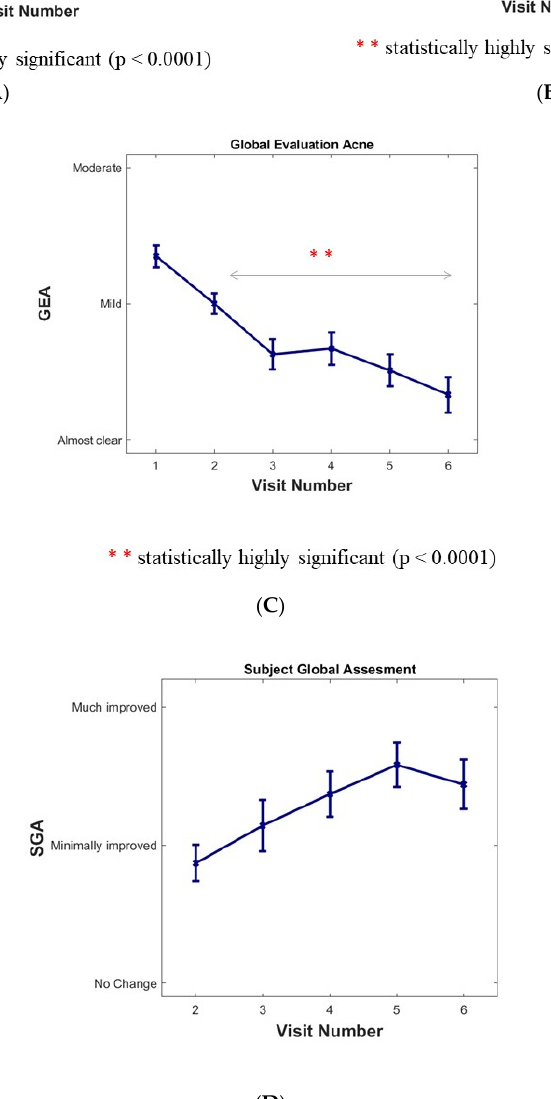
Figure 2. ( A ) Assessment of acne in cohort population: Acne lesion count. ( B ) Inflammatory and Non-inflammatory acne lesions (open and closed comedones). Results are expressed as means ± SD; a sustained, statistically significant decrease versus baseline after 6 months (Visit 4) and 12 months (Visit 6) for lesion count ( p < 0.0001). ( C ) Acne assessment using the investigator Global Evaluation of Acne (GEA). Results are expressed as means ± SD. p value < 0.0001 for ∆ (Vx-V1) x = 2 to 6. ( D ) Subject’s Global Assessment (SGA) of acne improvement after the 6- and 12-month